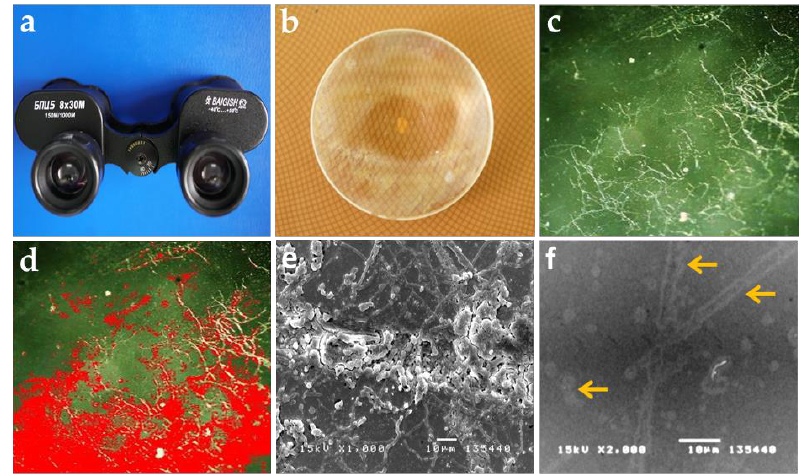
Figure 1. ( a ) The binocular model. ( b ) Binocular eyepieces contaminated with fungi. ( c ) Image captured using light microscopy at a magnification of 60×. ( d ) The estimation of hyphae covering the glass surface treated by the ImageJ tool. ( e ) SEM image exhibiting the fungal growth and colonization on the eyepieces (image at a magnification of 1000×, scale bar = 10 µm). ( f ) Yellow arrows indicate fingerprinting/etching of fungal hyphae on the surface of eyepieces after the cleaning procedure (image at a magnification of 2000×, scale bar = 10 µm). Table 1. The extent of fungal hyphae on eyepiece samples. Place Glass Sample